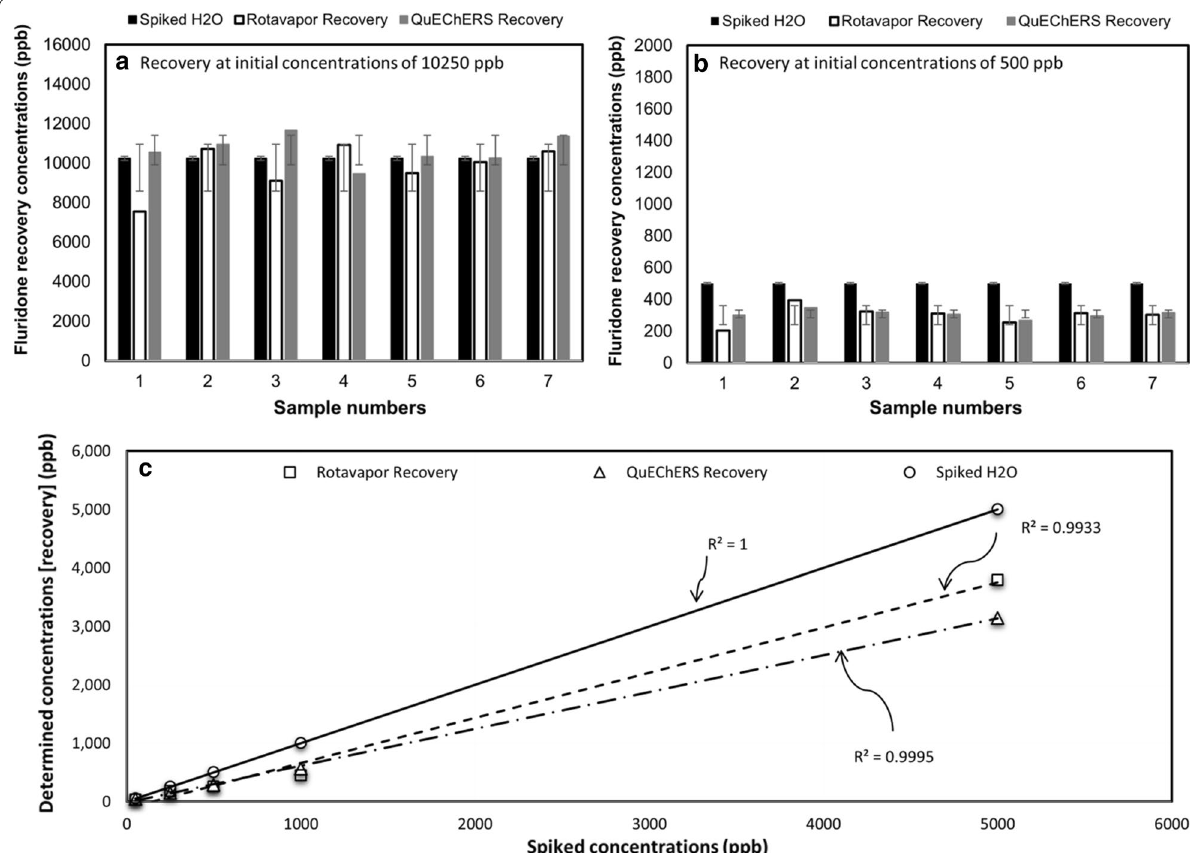
Fig. 4 Results of spiked water, rotavapor method (RM) recovery, and QuEChERS Method (QM) recovery: a recovery at high concentrations (10,250 ppb); b recovery at low concentrations (500 ppb); and c linearity test at various concentrations of fluridone in water and